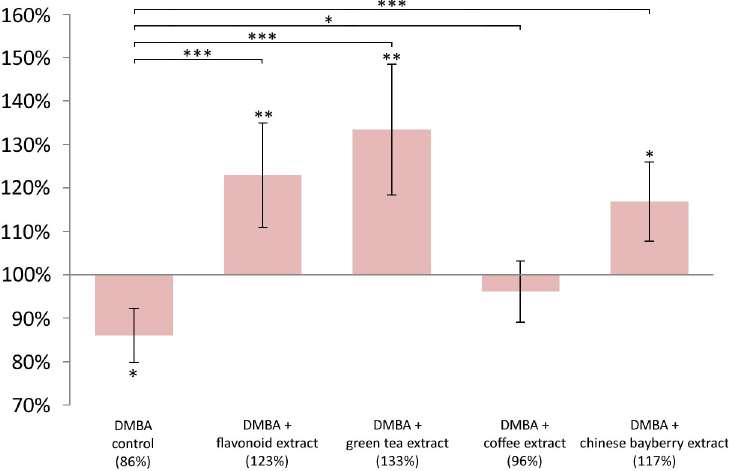
Fig 2. LINE -1 methylation pattern in the spleen of mice. LINE-1 methylation pattern in the spleen of CBA/Ca female mice (n = 6) due to the effect of DMBA, flavonoid extract, green tea extract, coffee extract and chinese bayberry extract, expressed as the ratio of untreated control ( � p < 0.05, �� p < 0.005, ��� p < 0.001). The mean LINE-1 DNA methylation level compared to negative control in the liver was in DMBA treated group 81%, in coffee group 92%, in flavonoid extract group 131%, in green tea extract group 112% and in chinese bayberry group 104% (Fig 1). The mean LINE-1 DNA methylation level compared to negative control in the spleen was in DMBA treated group 86%, in coffee group 96%, in flavonoid extract group 123%, in green tea extract group 133% and in chinese bayberry group 117% (Fig 2). The mean LINE-1 DNA methylation level com- pared to negative control in the kidneys was in DMBA treated group 89%, in coffee group 119%, in flavonoid extract group 112%, in green tea extract group 99% and in chinese bayberry group 92% (Fig 3).